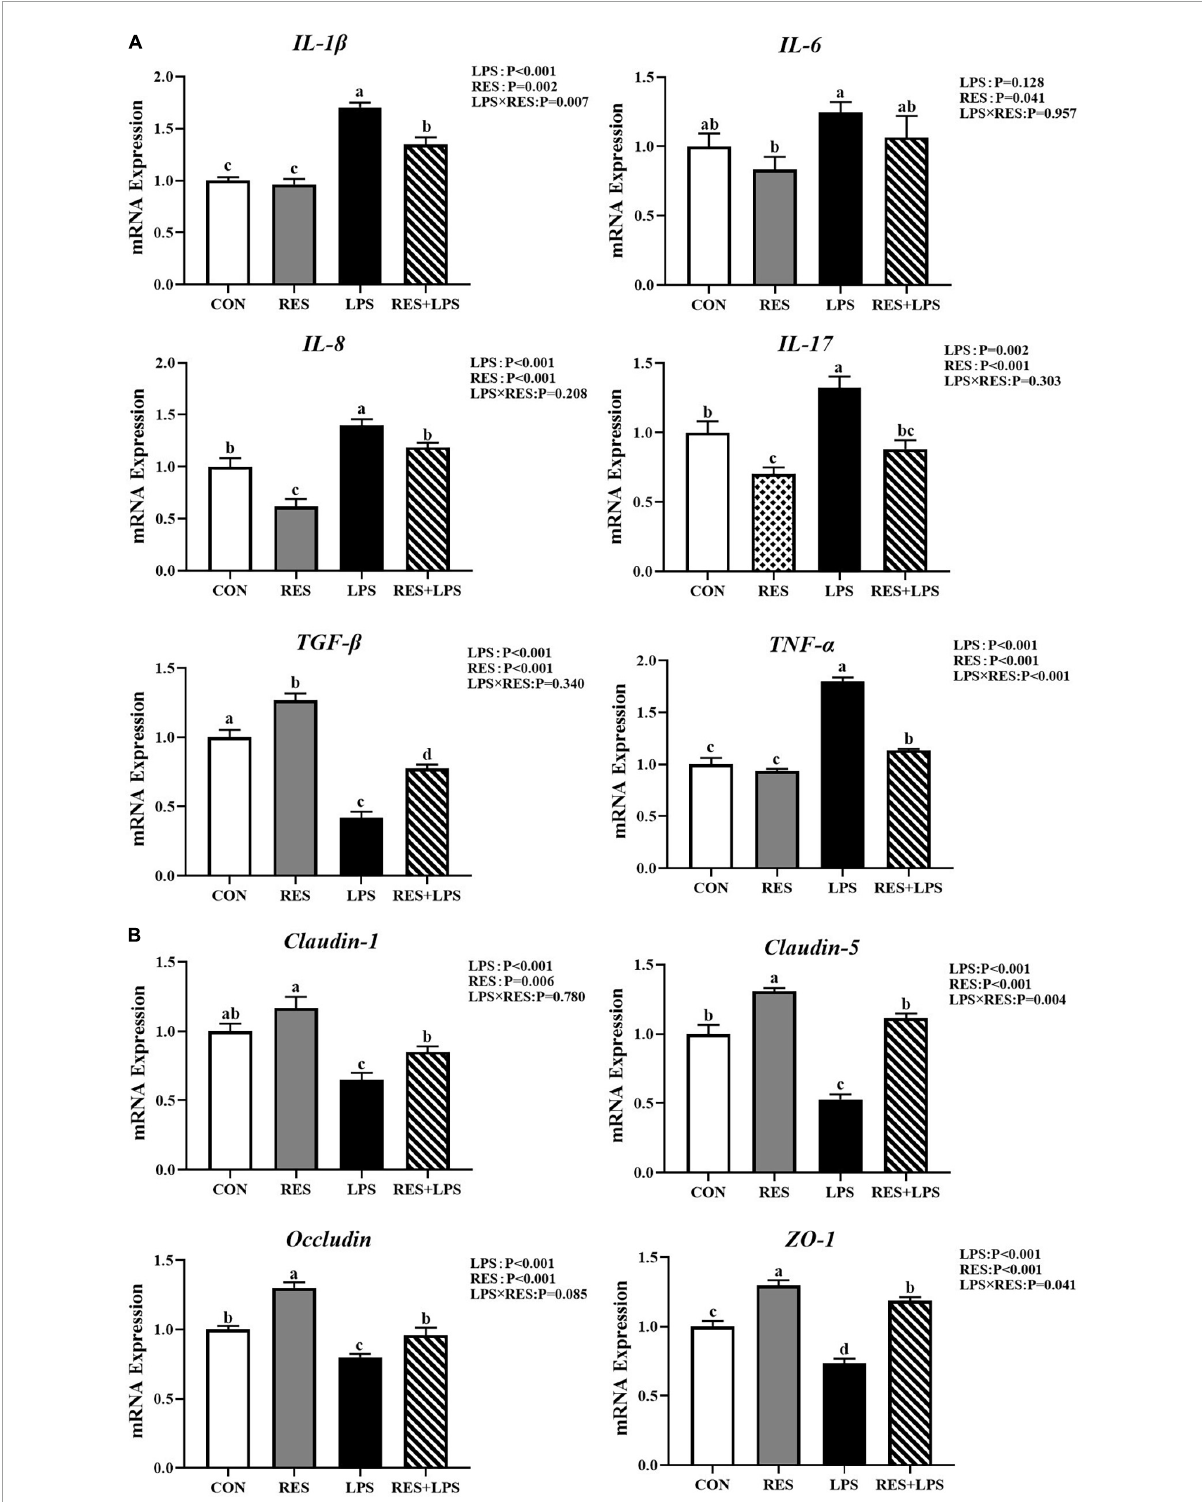
FIGURE2 Effect of dietary resveratrol supplementation on intestinal gene expression in yellow-feathered broilers with lipopolysaccharide. (A) The mRNA expression of intestinal cytokines. (B) The mRNA expression of tight junctions. Values are means and standard error of the means, n = 5 per treatment. abc Means in the columns with different superscripts differ ( P < 0.05). CON, control; RES, resveratrol; LPS, lipopolysaccharide; RES + LPS, dietary resveratrol treatment followed by LPS